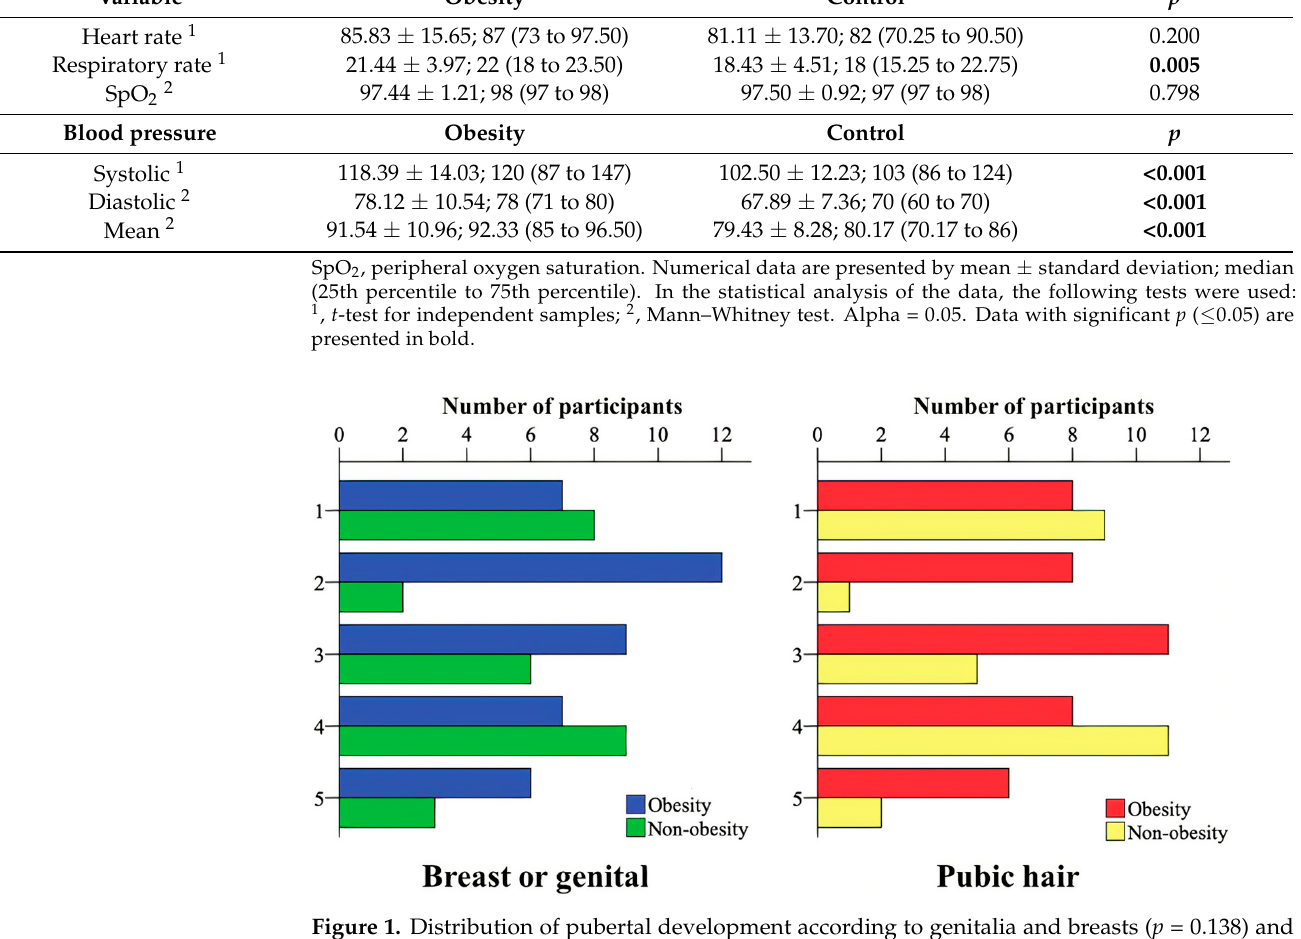
Figure 1. Distribution of pubertal development according to genitalia and breasts ( p = 0.138) and pubic hair ( p = 0.089) between the groups with and without obesity.